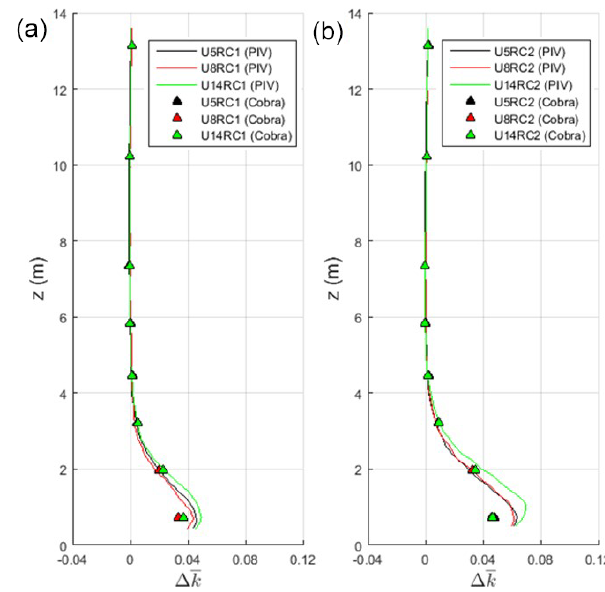
Figure 19. Vertical profiles of TKE increment (cid:49)k from WindEEE PIV and Cobra probe at M6 for (a) RC1 and (b) RC2